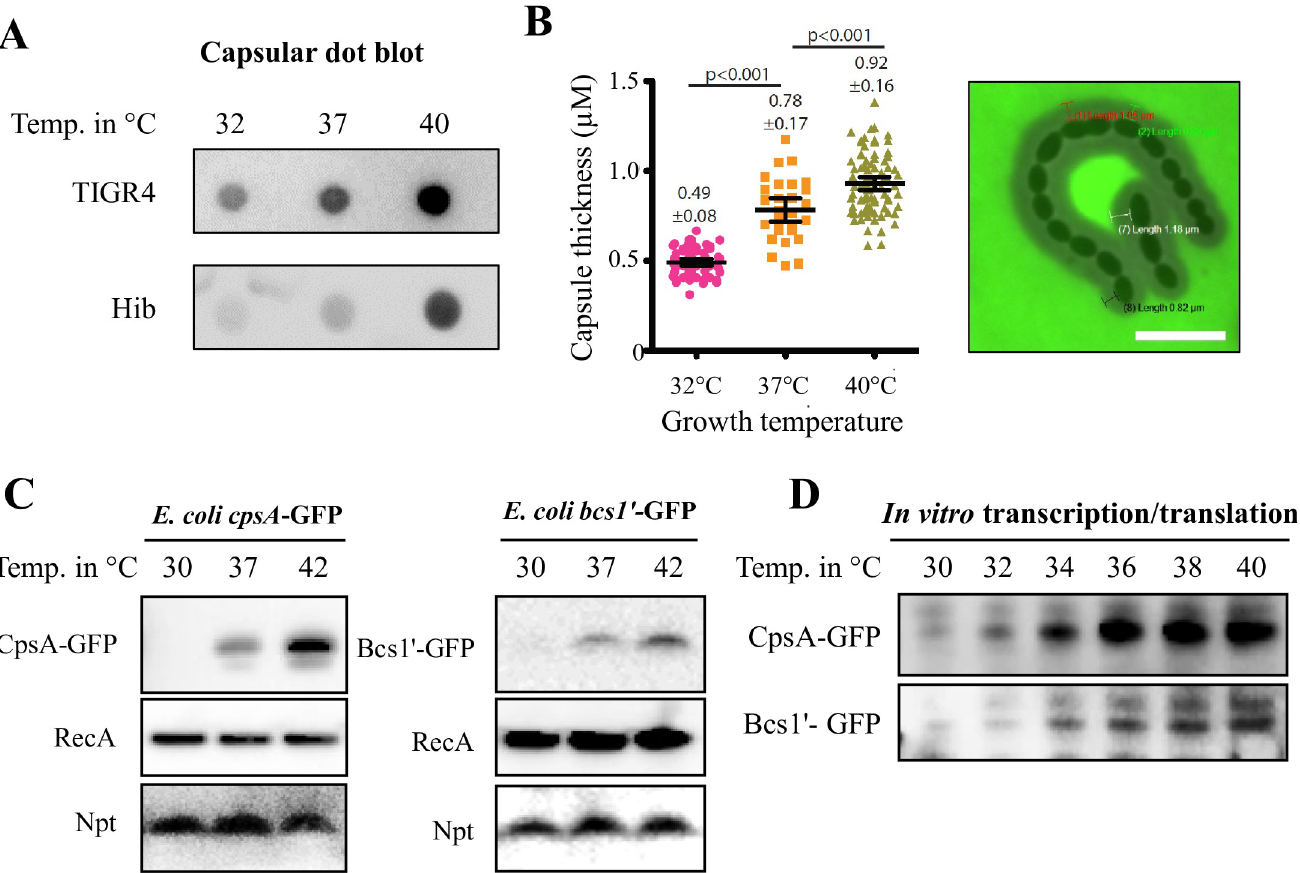
Fig 2. Capsular gene expression and production of capsules of S . pneumoniae and H . influenzae are temperature regulated. (A) Capsular dot blot analyses of S . pneumoniae and H . influenzae type b (Hib) show increased presence of capsular components in culture supernatants with increasing temperature. Pneumococcal Serotype 4 and H . influenzae type b polysaccharide capsule specific anti-sera were used for detection of capsules. (B) The S . pneumoniae capsule is thicker at higher temperature as shown by dextran exclusion assay (right panel, bar = 5 μ m). The average thickness of pneumococcal capsules ( μ m) grown at different temperature were tabulated and shown in the graph with standard deviations (+/-). (C) Thermoregulation of CpsA and Bcs1´ UTR- gfp fusion products detected in E . coli by Western blot analysis (Anti-GFP antibody used for detection of GFP, RecA and Neomycin-phosphotransferase used as controls). (D) Western blots of in vitro transcription/translation assay of CpsA and Bcs1´ UTR- gfp fusion products show temperature regulation of CpsA-GFP and Bcs1´-GFP. (Anti-GFP antibody used for detection of GFP). Error bars denote s.e.m. Statistical significance calculated using a paired, two-tailed student t-test.